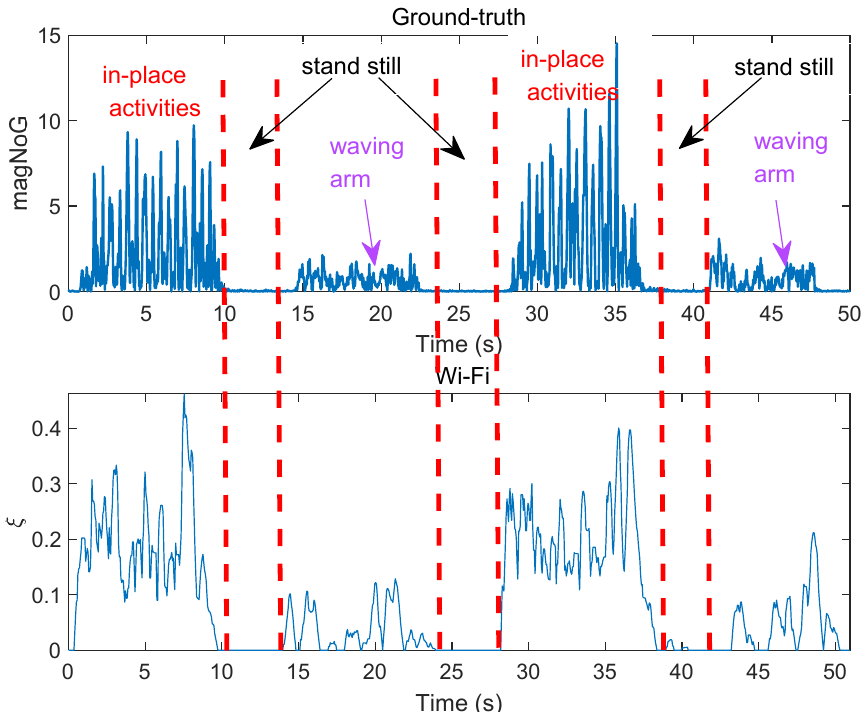
Figure 12. The ground-truth and the CSI metric ξ of two